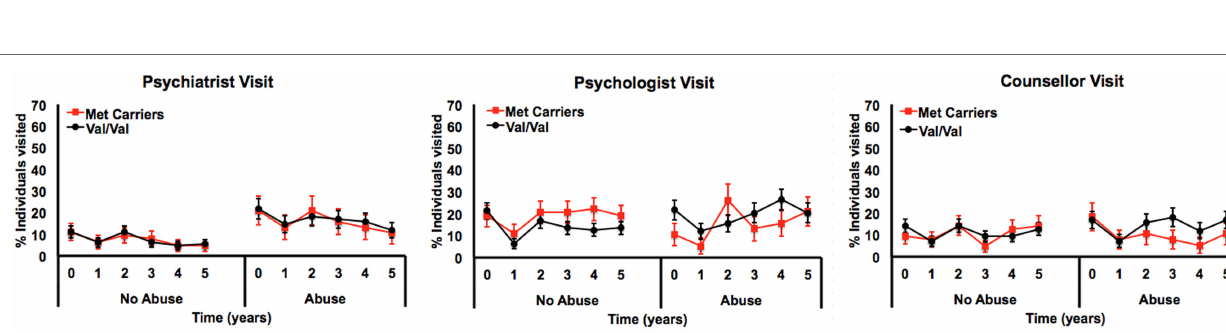
FigUre 4 | longitudinal measurements of medication usage by percent of individuals reportedly taking the medication by genotype and history of severe child abuse .